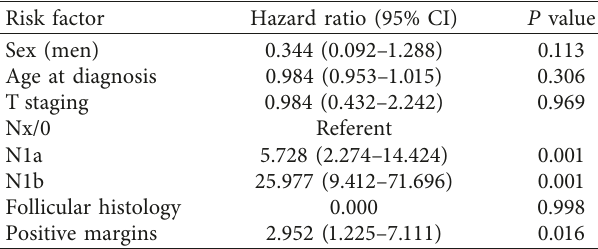
Table 6: Multivariate analysis of factors affecting